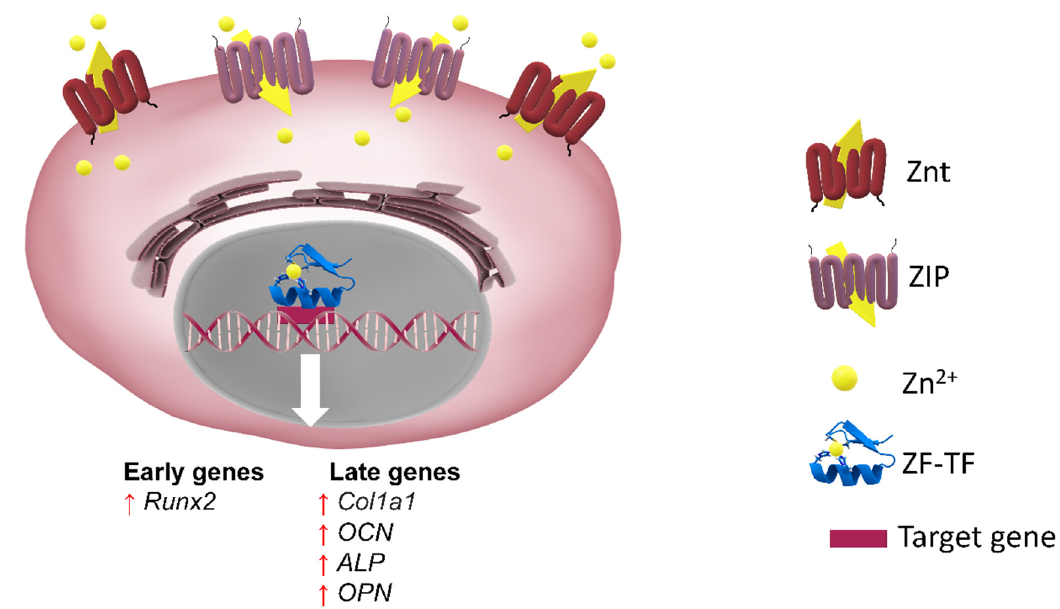
Figure 7. Representation of the zinc transport process across membranes, mediated by specific importers and exporters, to Zrt- and Irt-like protein (ZIP) and the zinc transporter (ZnT). At the cytoplasmic level, zinc is important for the functionality of zinc finger transcription factors (ZF-TFs) that regulate the transcription of early and late genes in osteoblastic differentiation. Refer to the text for a detailed description.